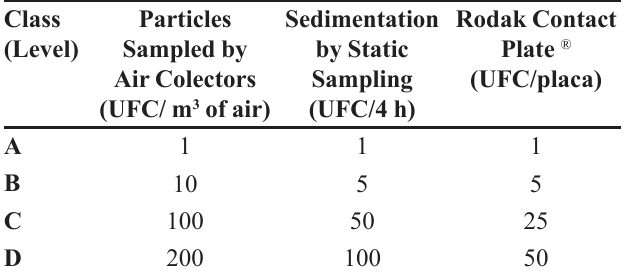
TABLE VII - Microbial contamination limits recomended by